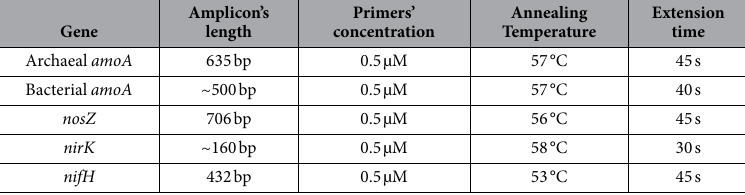
Table 8. Conditions for the different primers in the RealTime